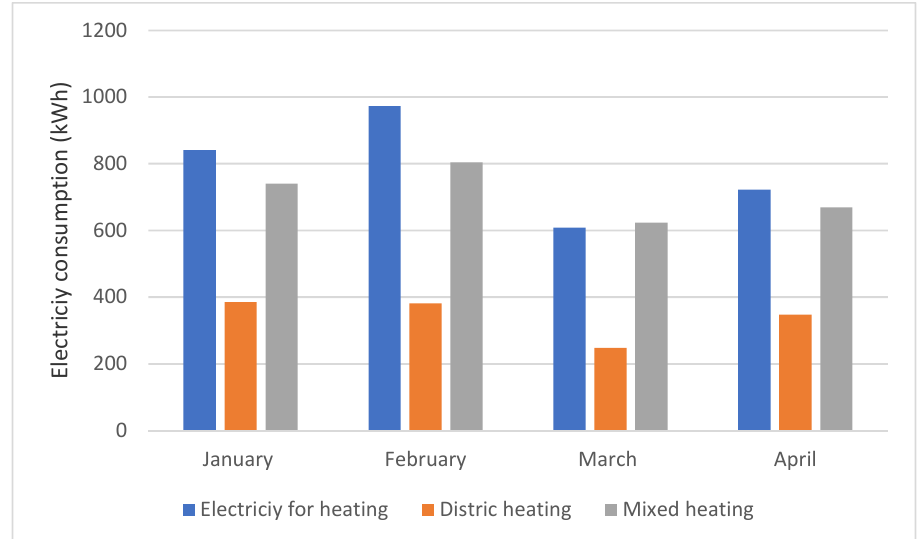
Figure 1. Electricity consumption in selected household groups in Serbia, depending on the heating energy source (2019).